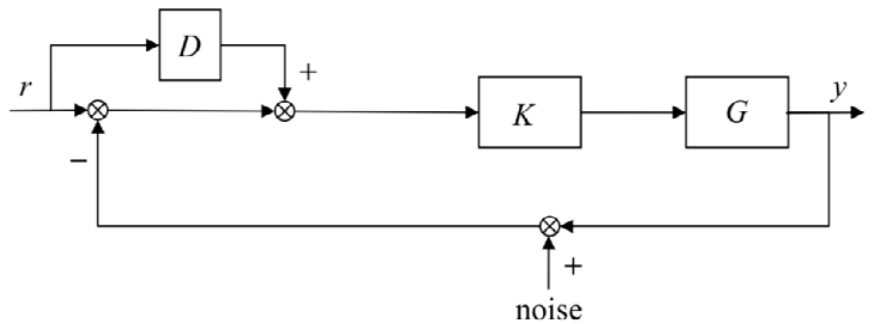
Figure 10. Composite control sketch of the piezo-based